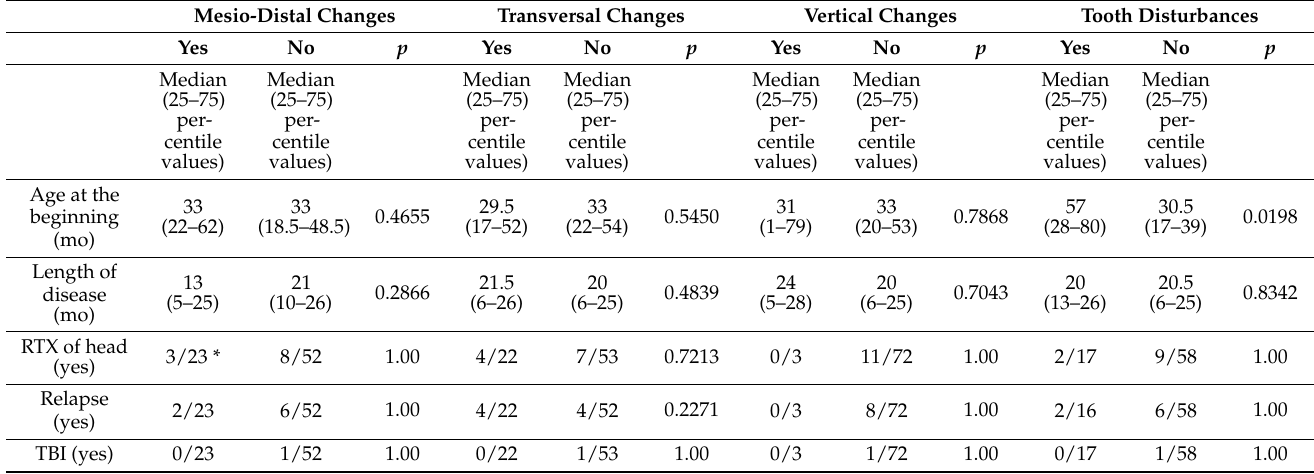
Table 5. Cancer-related variables in patients with different types of